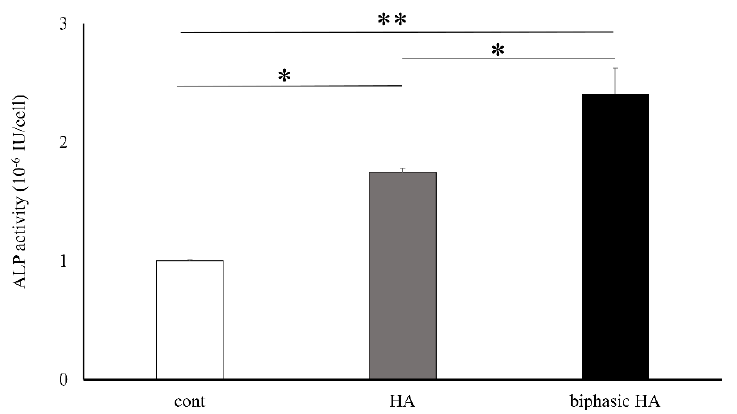
Figure 9. Bone differentiation ability of HA granules and biphasic HA granules (n = 4, * p < 0.05 ** p < 0.01).